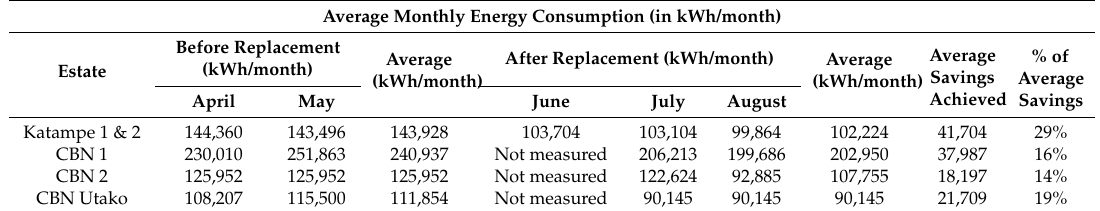
Table 4. Average monthly bill in estates before and after replacement (Source: